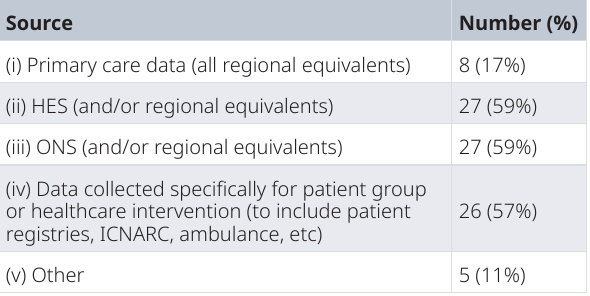
Table 2. Categories of RCHD sources of outcome data in 46 studies where this was the sole source for at least one